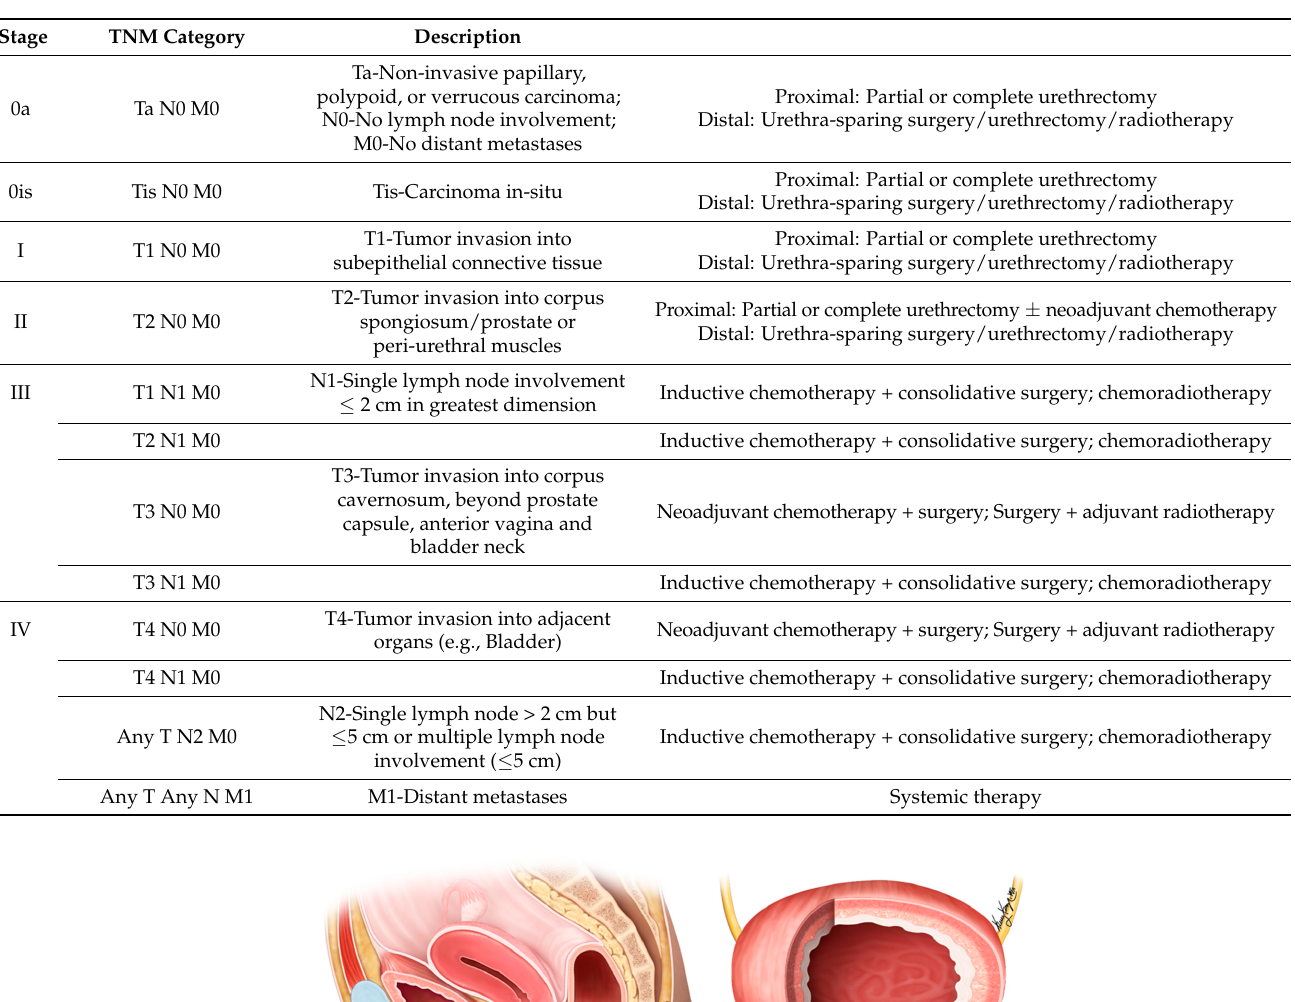
Table 11. AJCC staging of urethral malignancies [129].